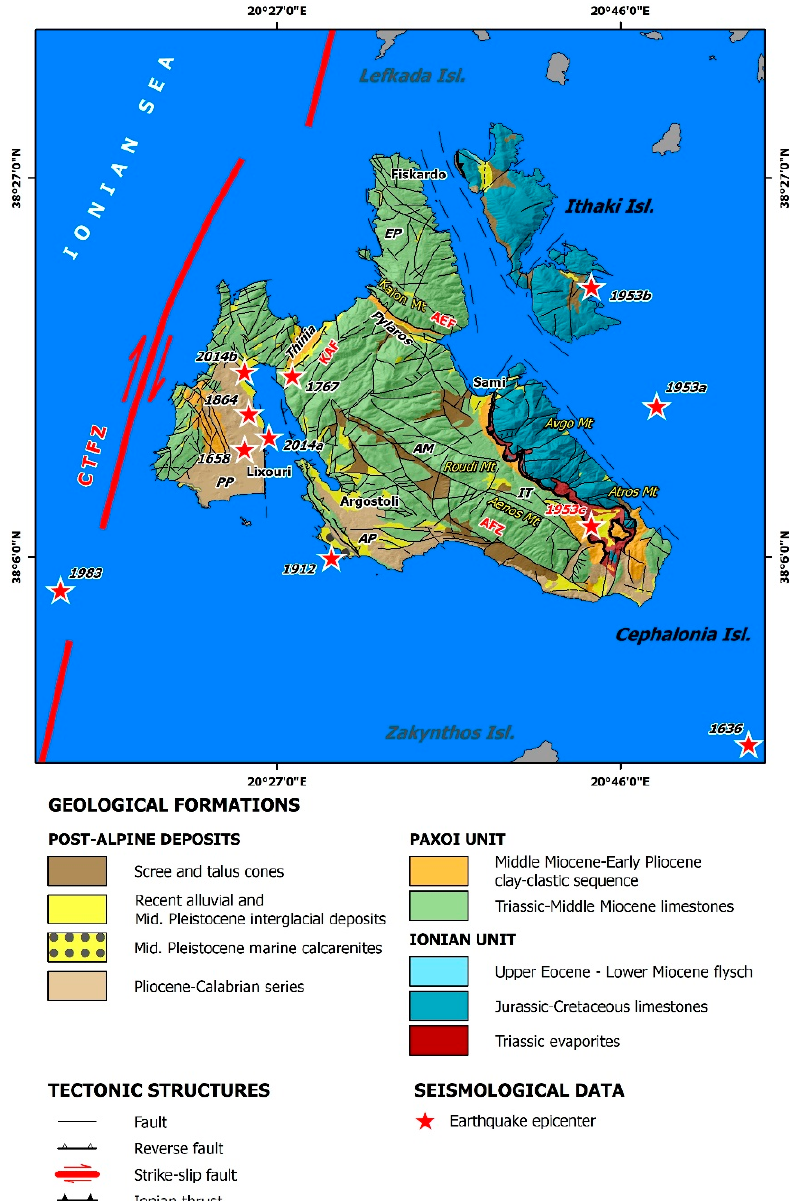
Figure 3. The neotectonic map of Cephalonia along with epicenters of historical and recent earth- quakes that triggered landslides in the island. Fault blocks are also noted (EP: Erissos peninsula, AM: Aenos Mt fault block, AP: Argostoli peninsula, PP: Paliki Peninsula) along with their marginal faults (AEF: Ayia Efimia Fault, KAF: Kontogourata–Agonas Fault, CTFZ: Cephalonia Transform Fault Zone) and other major structures (IT: Ionian Thrust).